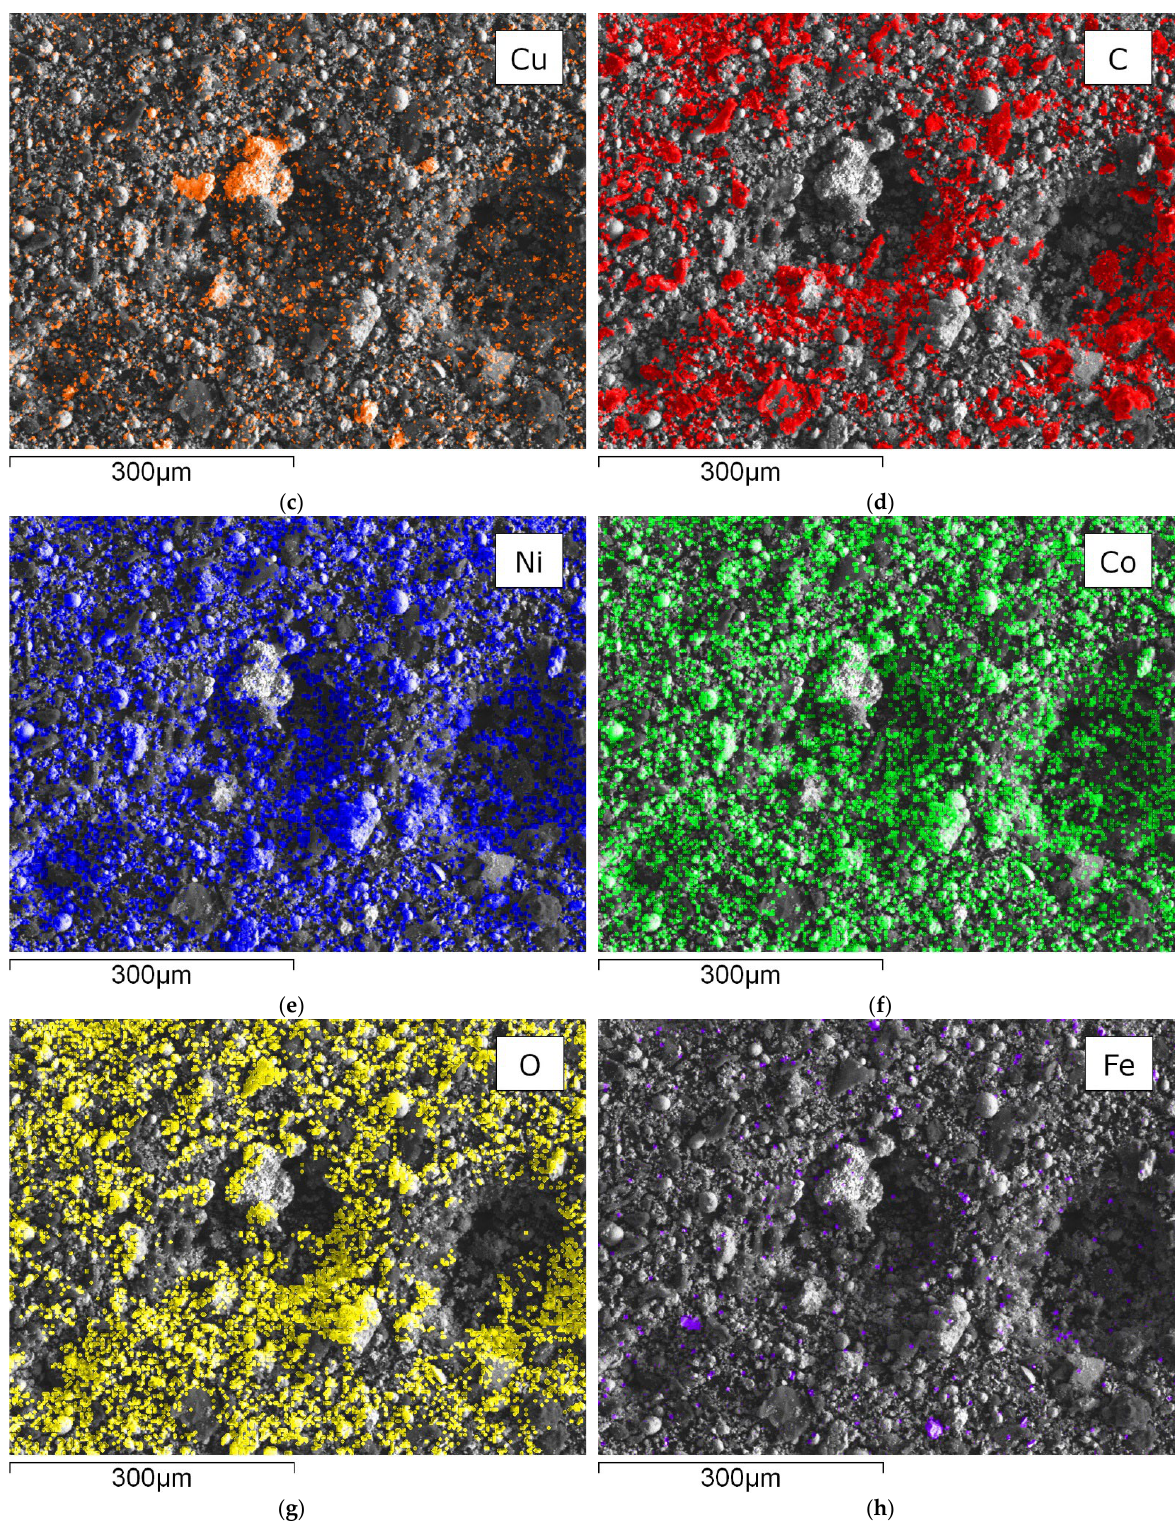
Figure 5. SEM picture and overlay of the elemental distribution of characteristic elements; ( a ) SEM picture of NCA_AM, one of the characteristic NCA agglomerates is marked in red; EDX-Mapping of ( b ) aluminum; ( c ) copper; ( d ) carbon; ( e ) nickel; ( f ) cobalt; ( g ) oxygen; ( h )